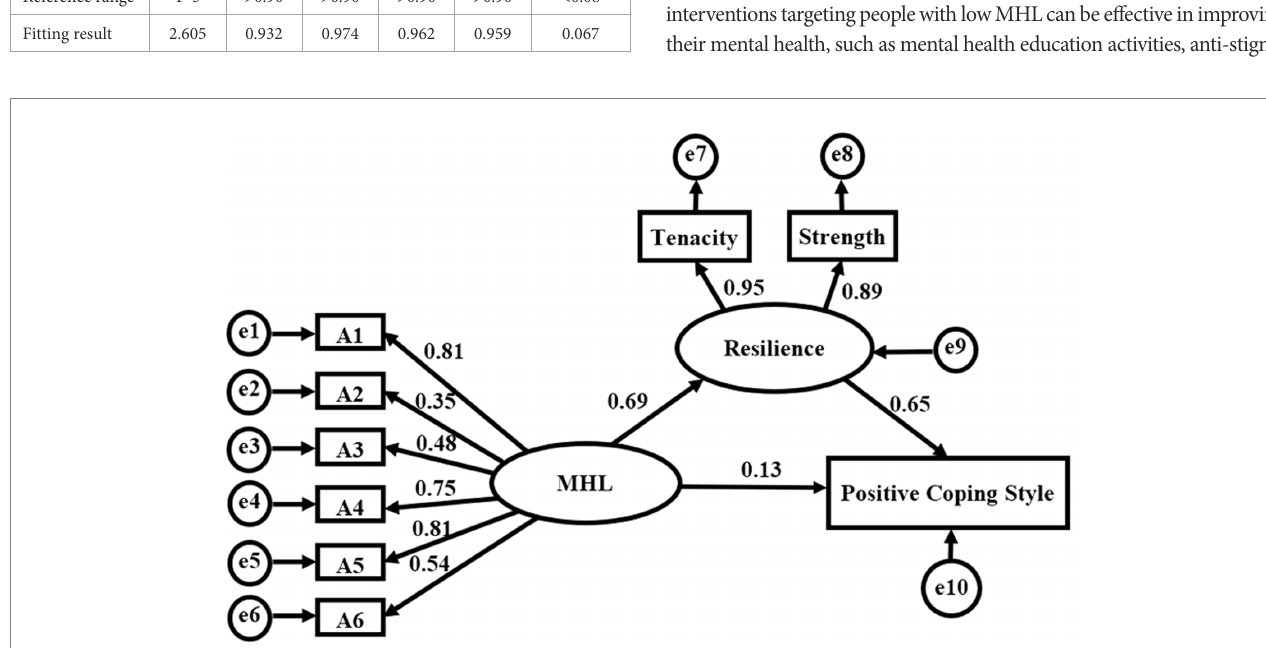
FIGURE 1 The structural equation model of MHL and resilience affecting positive coping style among empty nesters. A1: the ability to recognize mental illness; A2: the knowledge of causes and risk factors of mental illness; A3: the knowledge of self-treatment; A4: the knowledge of professional help available; A5: